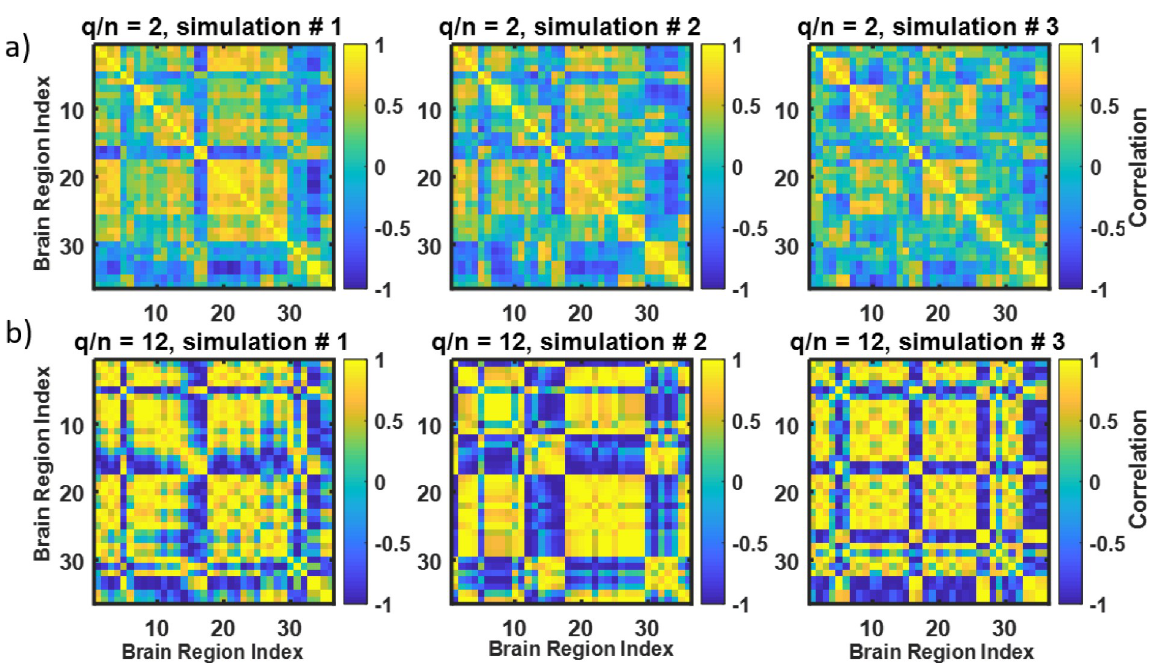
Fig 4. Increased variability of simulated correlation matrices with increased q/n value. A-3 instances of correlation matrices generated from the connectivity matrix #1 using q/n = 2, n = 18; B-3 instances of correlation matrices generated from the connectivity matrix #1 using q/n = 12, n = 3. See how variability of the matrices is increased in B ( q/n = 12 ) versus A ( q/n = 2 ).